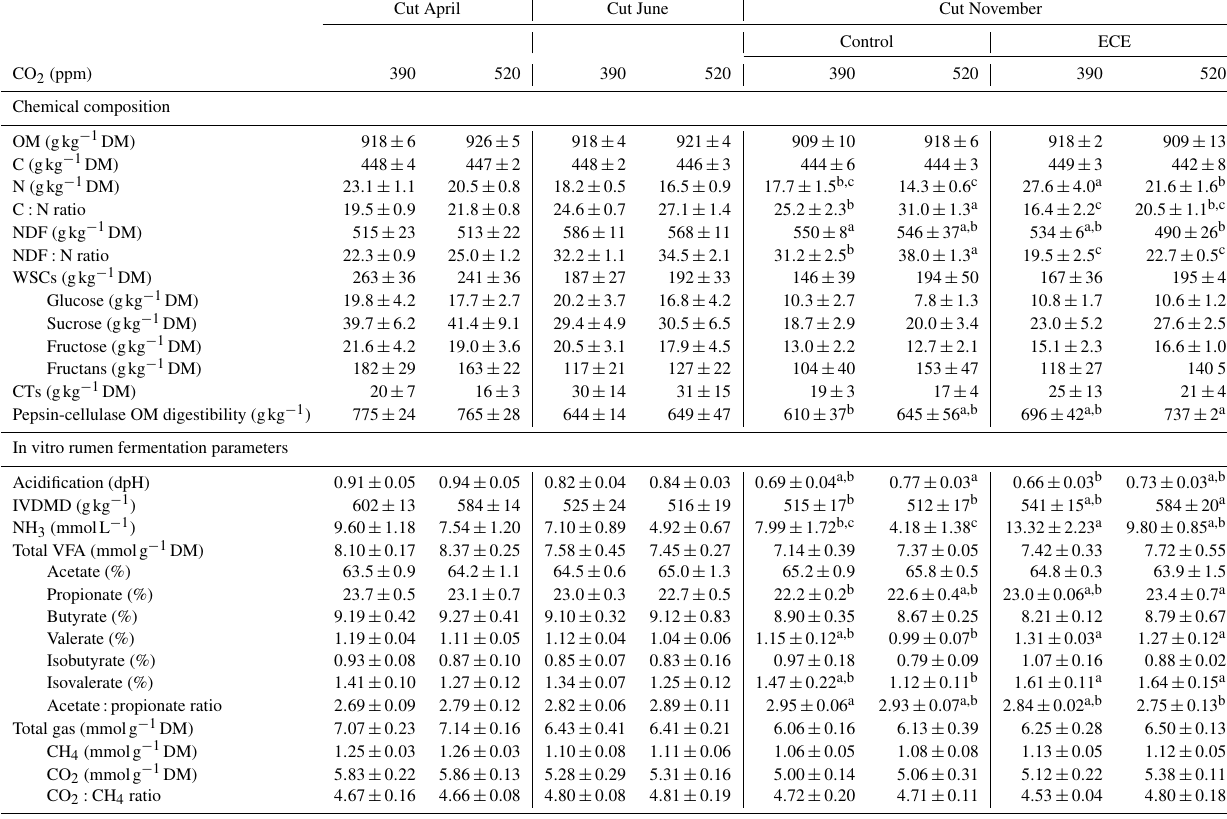
In vitro rumen fermentation